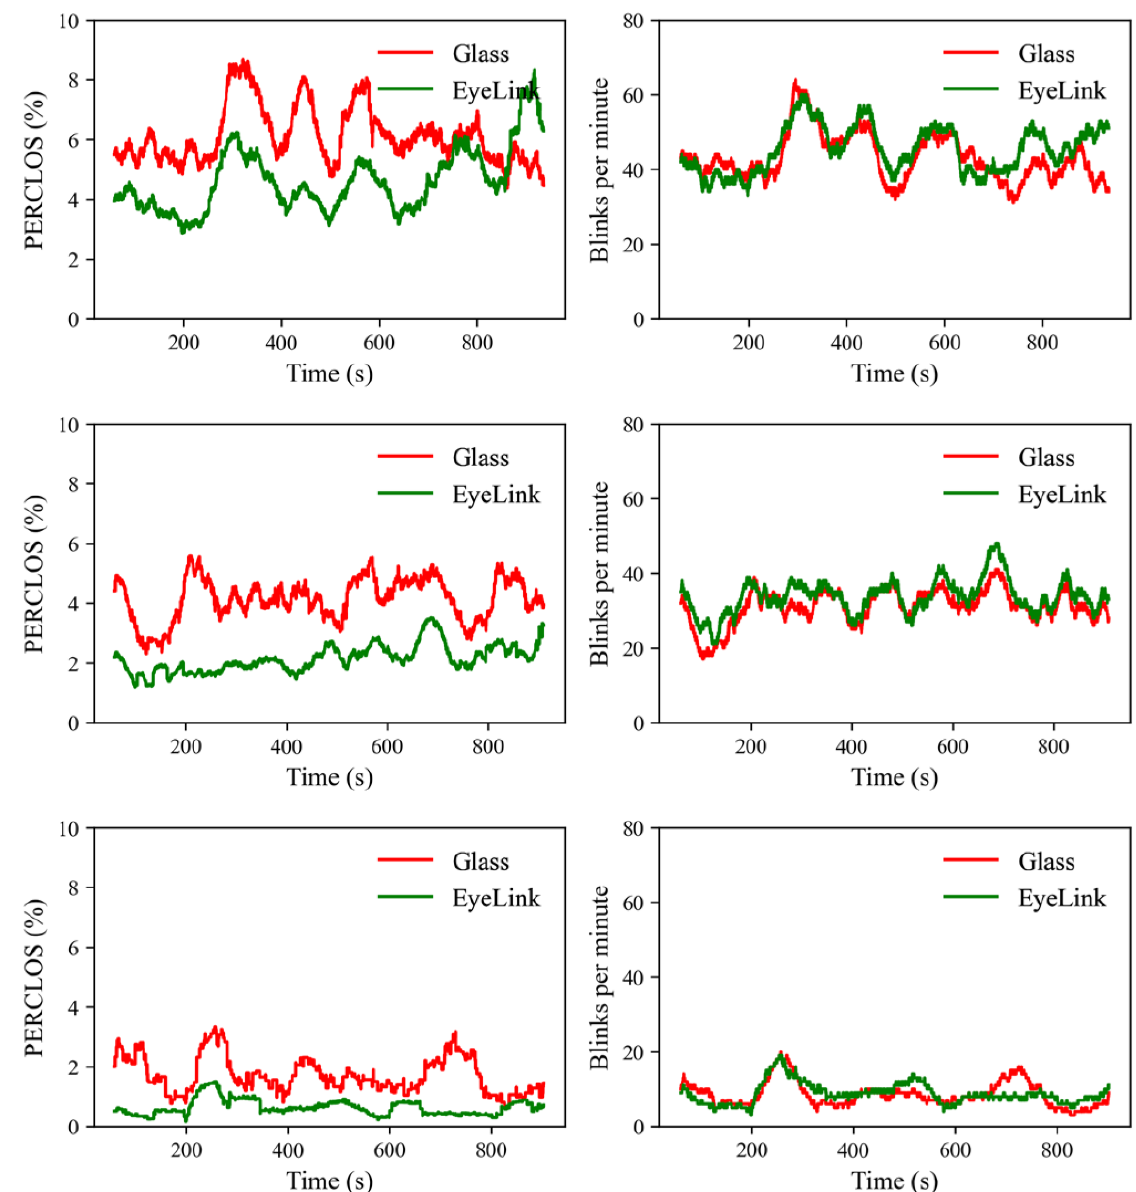
Figure 10. The PERCLOS ( left panel ) and blink rate ( right panel ) measures calculated from the three recording sessions.